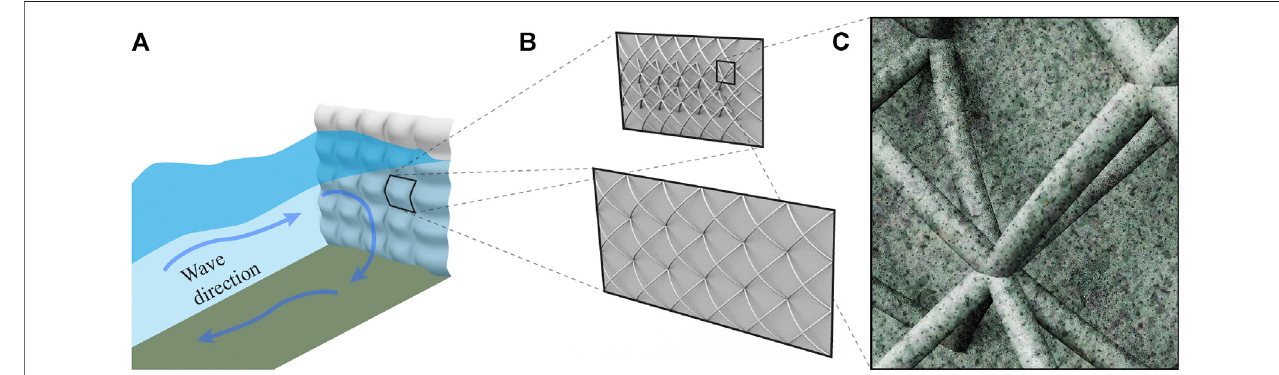
FIGURE14| Multifunctionalseawallpatterning — (A) — Large-scaleundulationsontheentirefaceoftheseawallsothatitisnopurelyvertical,andnolongercausing wave re fl ection and scour as shown with the blue arrows. (B) — A simple fractal pattern on an individual seawall tile. (C) — Magni fi cation of an individual seawall tile illustrating surface roughness and